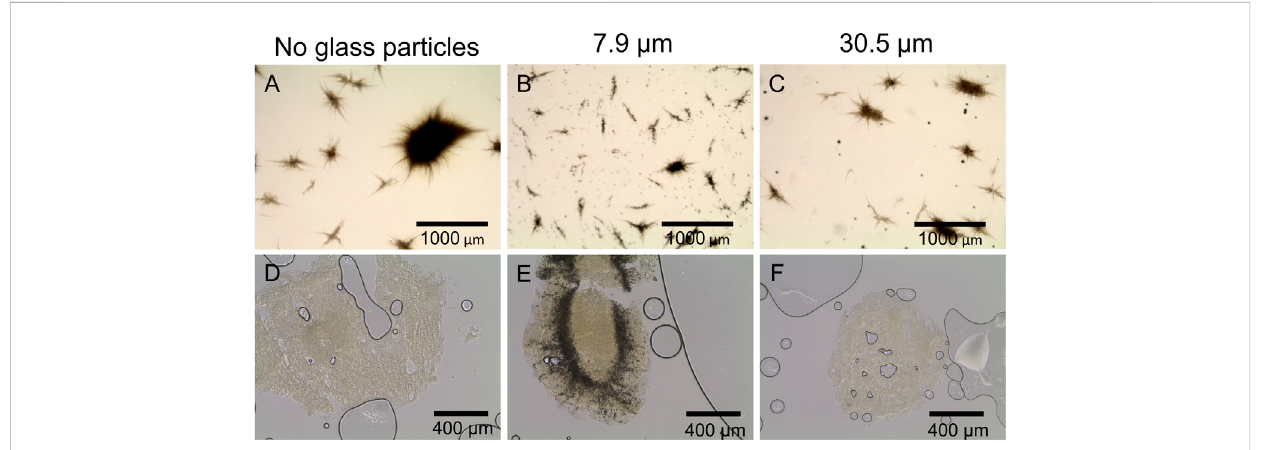
FIGURE 5 Microscopicimagesof L.aerocolonigenes (A) withoutand (B,C) withglassmicroparticleaddition(10 g L -1 ,x 50 =7.9and30.5 µm)and (D – F) ofpellet slices of the same microparticle setup. Here, black lines and circles are air bubbles enclosed in the sectioning medium. Dark areas in the pellets are incorporated glass